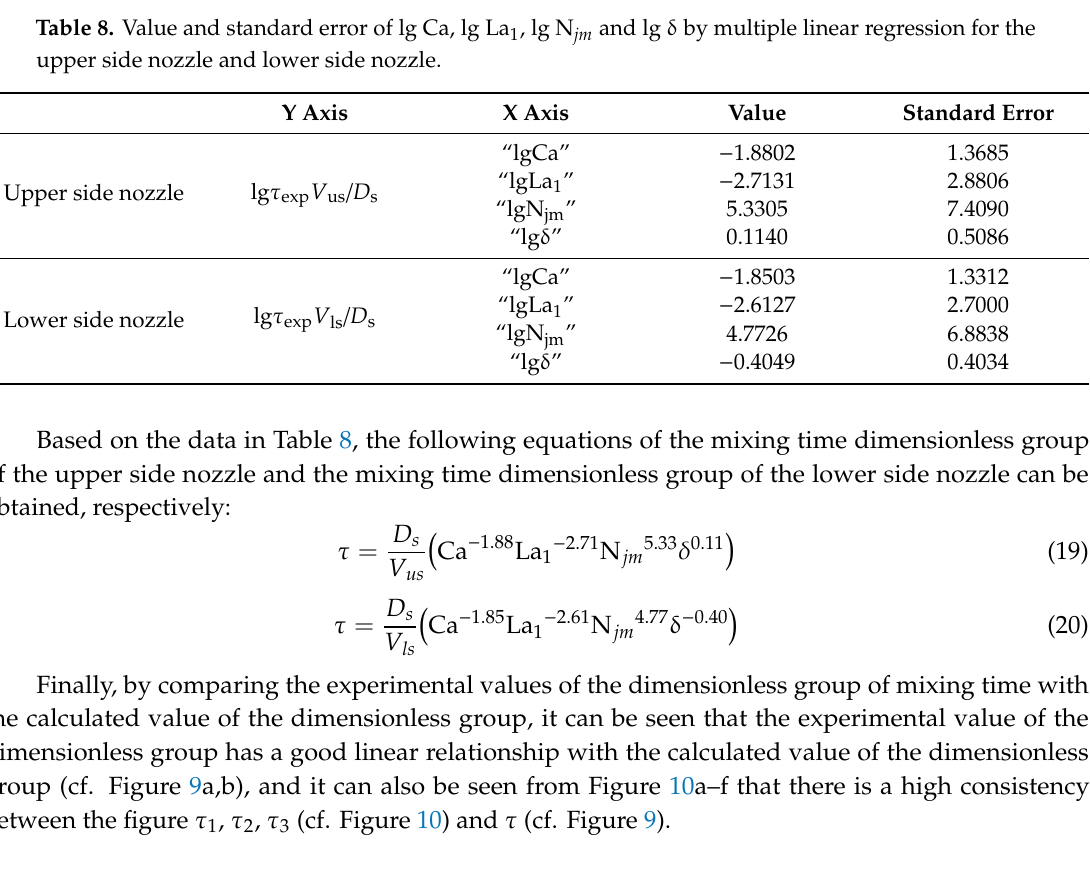
Figure 10. Comparison of experimental lg τV s / D s with calculated ones for upper side nozzle ( a – c ) and lower side nozzle ( d – f ), respectively, using 𝜏𝜏 1 , 𝜏𝜏 2 , 𝜏𝜏 3 . 4.4. The Effects of Ca, La 1 , N jm , δ, H i and h i The position of the tracer feeding position and the insertion depth of the side nozzle are also important variable parameters. The expression of the dimensionless group of mixing time was studied after adding these two dimensionless groups. On the basis of the above dimensionless groups, the dimensionless group related to the tracer feeding position and the dimensionless group related to the insertion depth of the side nozzle was added unceasingly into the equation of mixing time dimensionless group. After substituting the parameters such as the flow velocity of upper side nozzle and the insertion depth of upper side nozzle into the Equation (14), multiple linear regression was performed through the origin, and the results are shown in in Table 9: